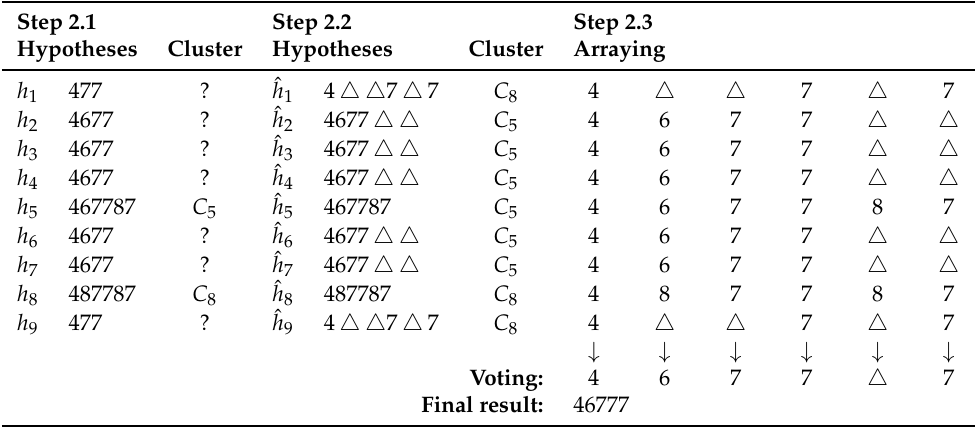
Table 2. Illustration of the cluster-based multiple-sequence alignment algorithm. The recognition confidence values of the digits are given in Table 1. The recognition confidence value of a space is set to